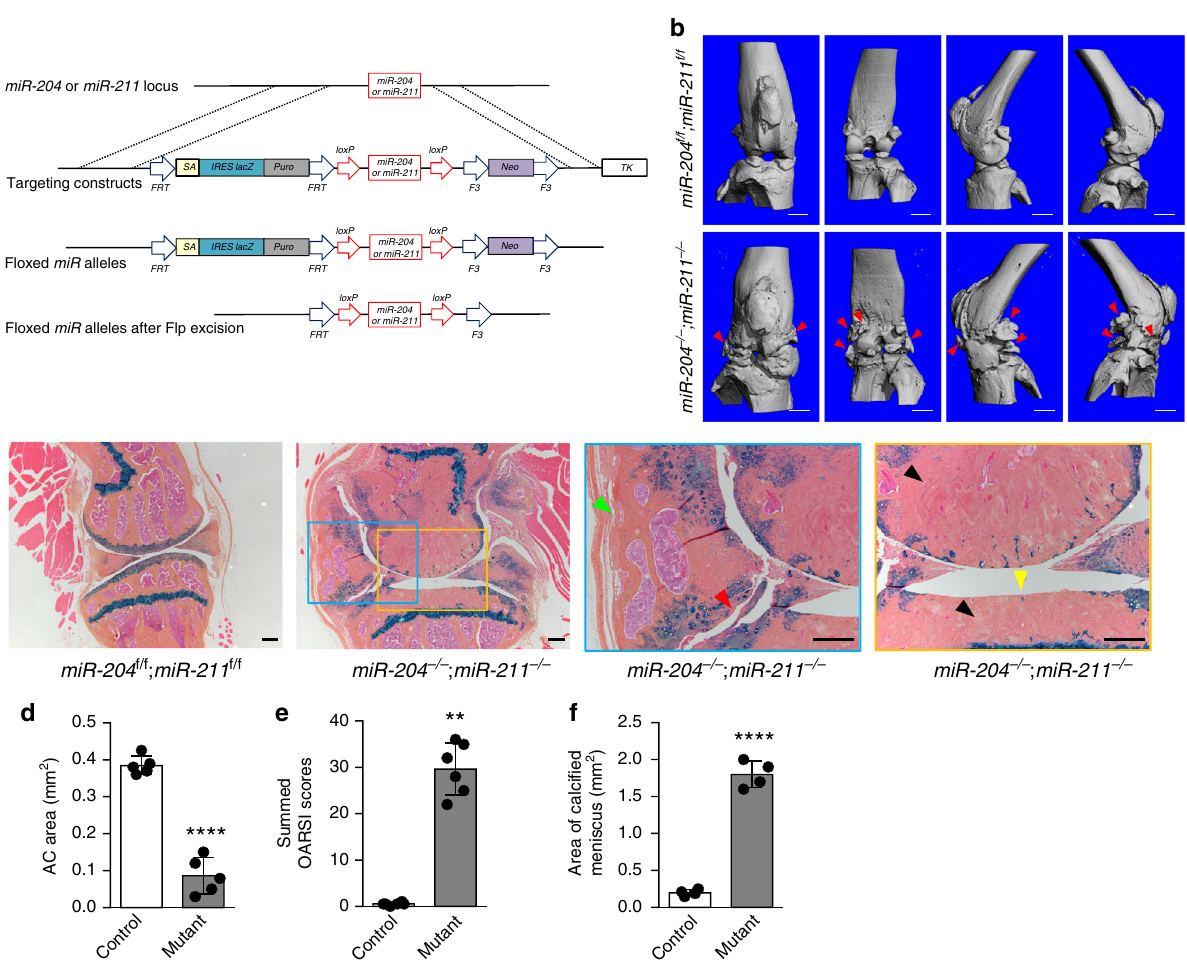
Fig. 1 Germline deletions of miR-204 / -211 cause multifaceted OA phenotype. a Schematic of miR-204 (or miR-211 ) conditional knockout (cKO) allele. Note that the contents, such as lines, boxes and arrows, are not proportional. b Representative μ CT images of 46-week-old miR-204 / -211 fl oxed (control) and global double knockout mice ( miR-204 − / − ; miR-211 − / − ). Red arrowheads, osteophytes. n = 5. Scale bar, 1mm. c Representative histology images of knee joints of 46-week-old miR-204 / -211 fl oxed mice and global double KO ( miR-204 − / − ; miR-211 − / − ) mice stained by Alcian blue/Orange G. Yellow arrowhead, loss of articular cartilage; red arrowhead, osteophytes; green arrowhead, synovial hyperplasia; black arrowheads, subchondral sclerosis. n = 5. Scale bar, 200 μ m. d , f Histomorphometric quanti fi cation of medial AC area ( d ), and calci fi ed meniscus area ( f ) of 46-week-old miR-204 / -211 fl oxed mice (control) and miR-204 − / − ; miR-211 − / − mice (mutant). **** P <0.0001, n = 4 or 5. Unpaired Student ’ s t test. e Osteoarthritis research society international (OARSI) scoring system was used to evaluate knee joint articular cartilage (AC) destruction in 46-week-old control and mutant mice. ** P <0.01, Mann − Whitney test. n =